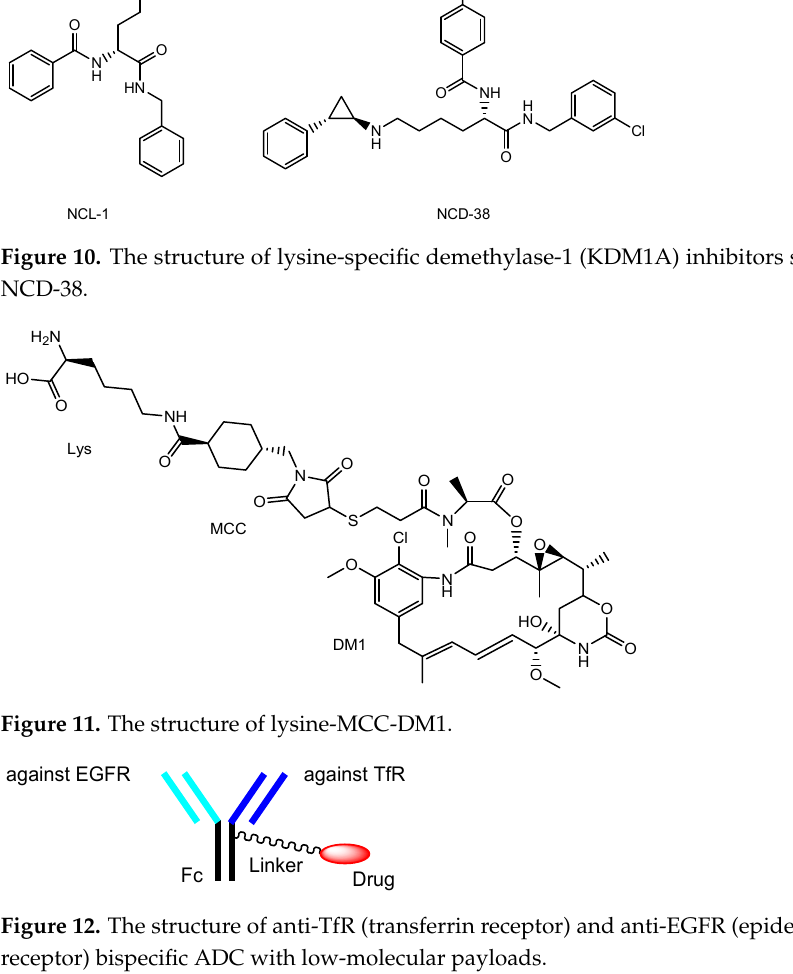
Figure 12. The structure of anti-TfR (transferrin receptor) and anti-EGFR (epidermal growth factor receptor) bispecific ADC with low-molecular payloads.